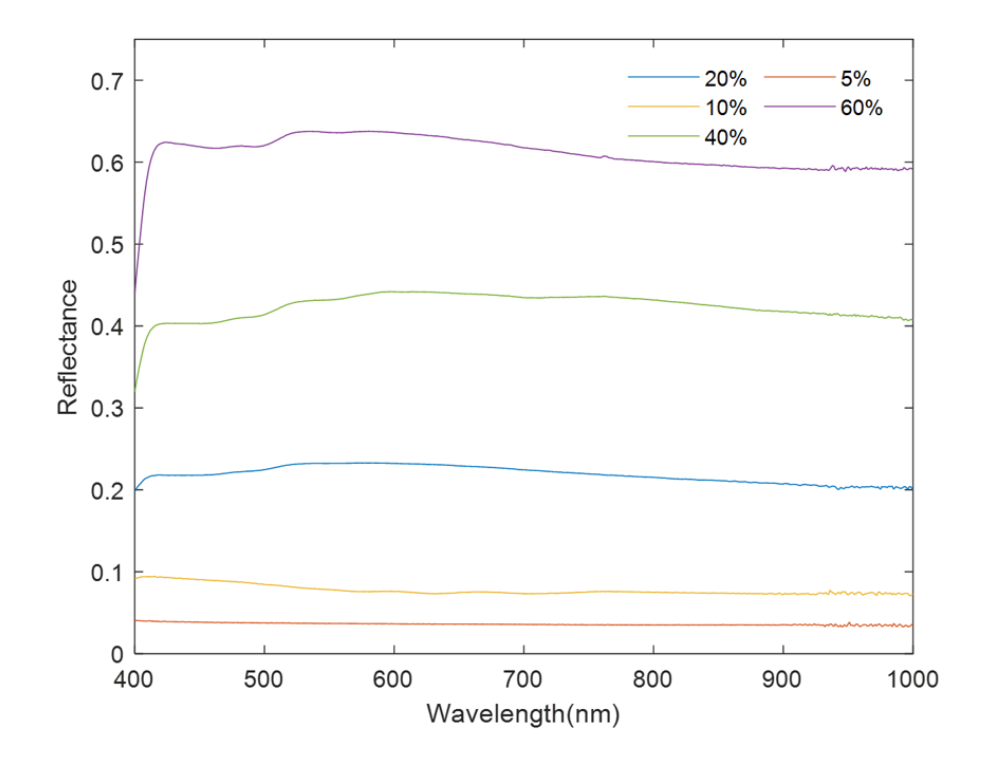
Figure 7. The measured reflectance curve of the calibration